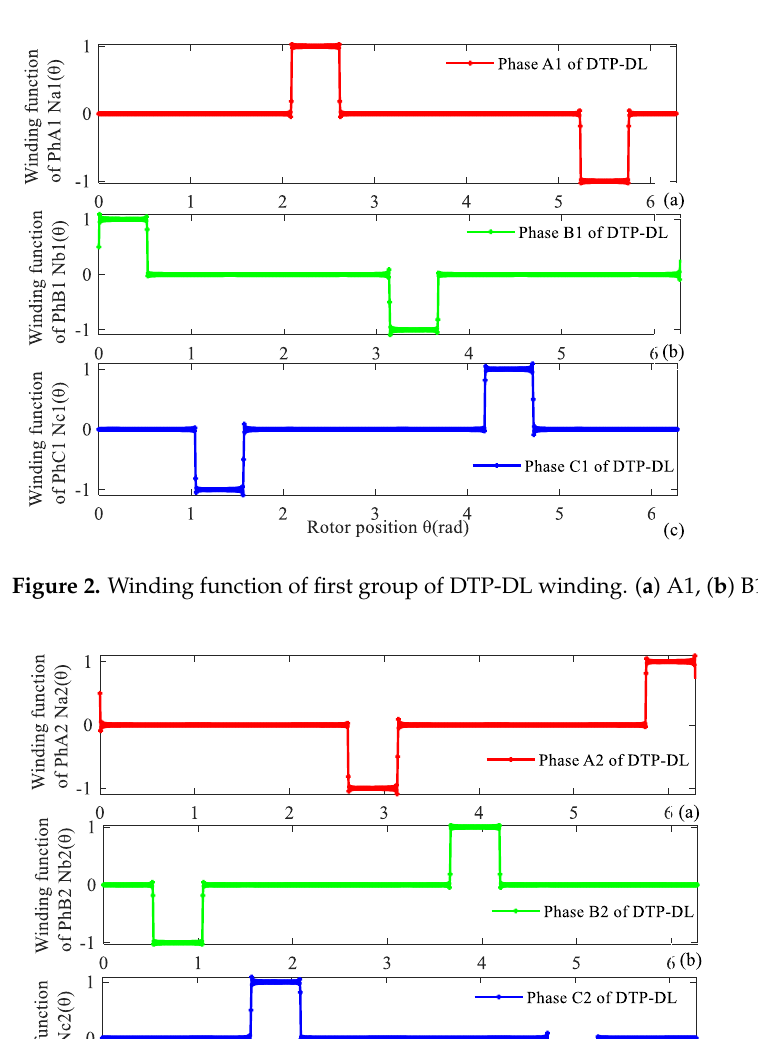
Figure 1. DTP-DL winding with 12-slot/10-pole combination. ( a ) Star graph, ( b ) winding layout. Winding function curve of DTP-DL winding is shown in Figures 2 and 3.